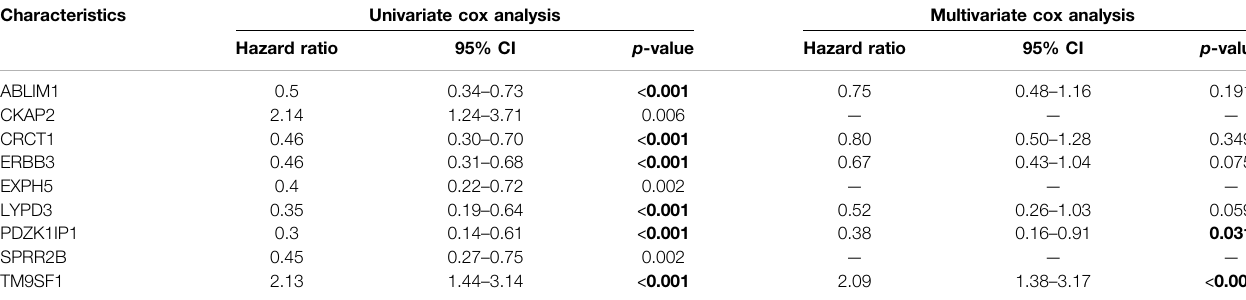
TABLE 2 | Univariate and multivariate Cox analysis of the expression of nine genes for patients from primary cohort ( n = 179). Characteristics